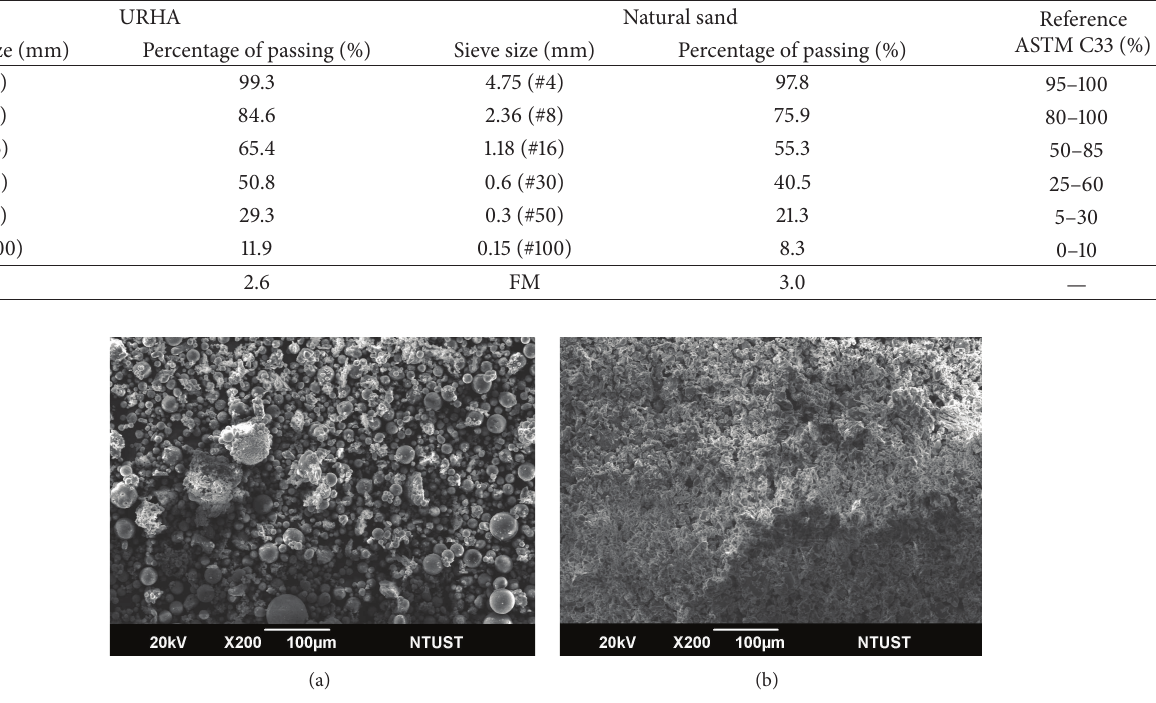
Table 2: Sieve analyses and fineness modulus (FM) for URHA and natural sand.